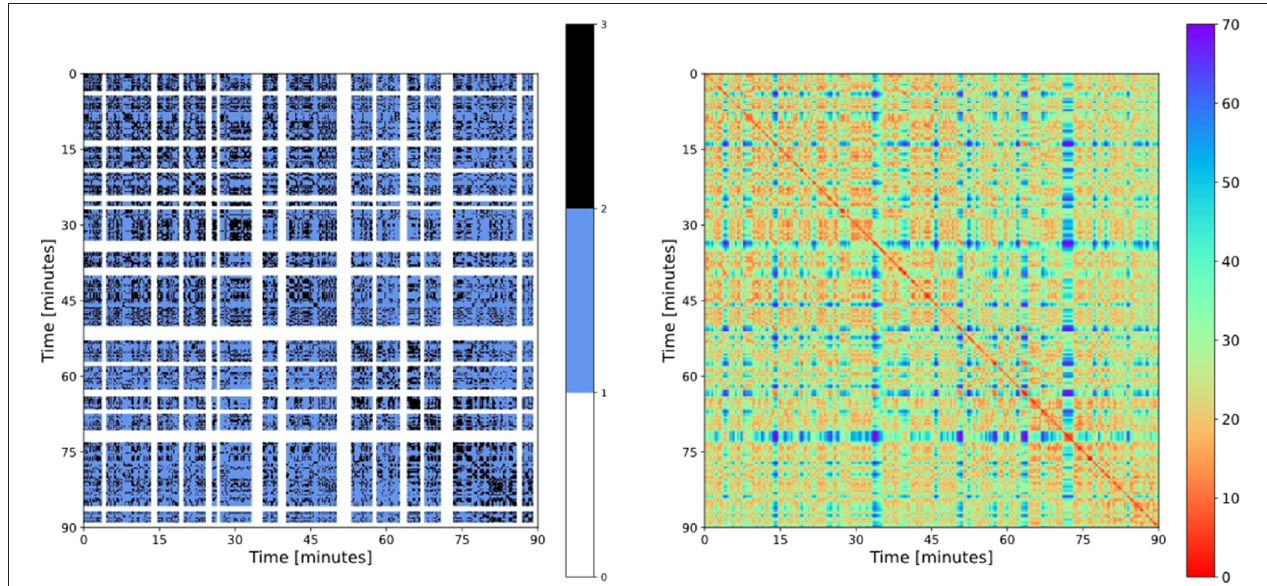
FIGURE 4 | (Left) RP with recurrent phases of open play provided by the pattern detection algorithm; (Right) color-coded RP of the same match.